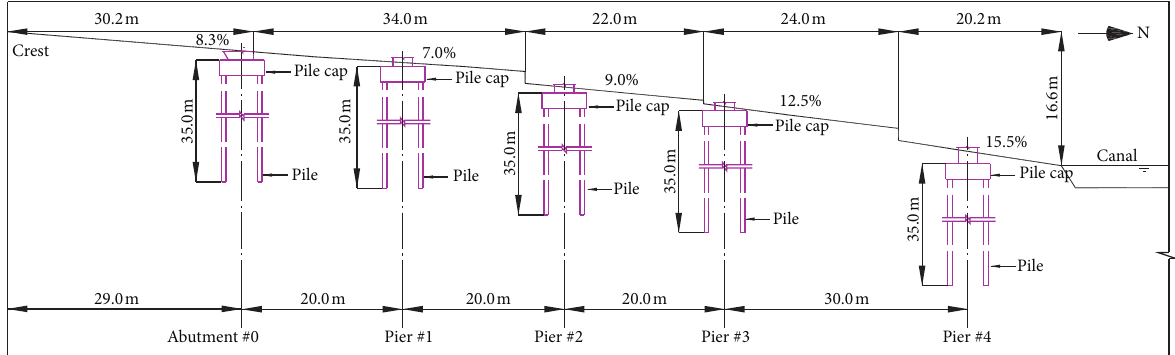
Figure 1: Schematic of the slope.